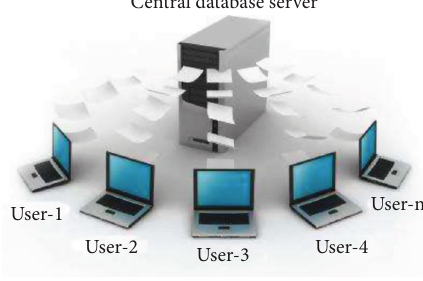
Figure 1: Central database system